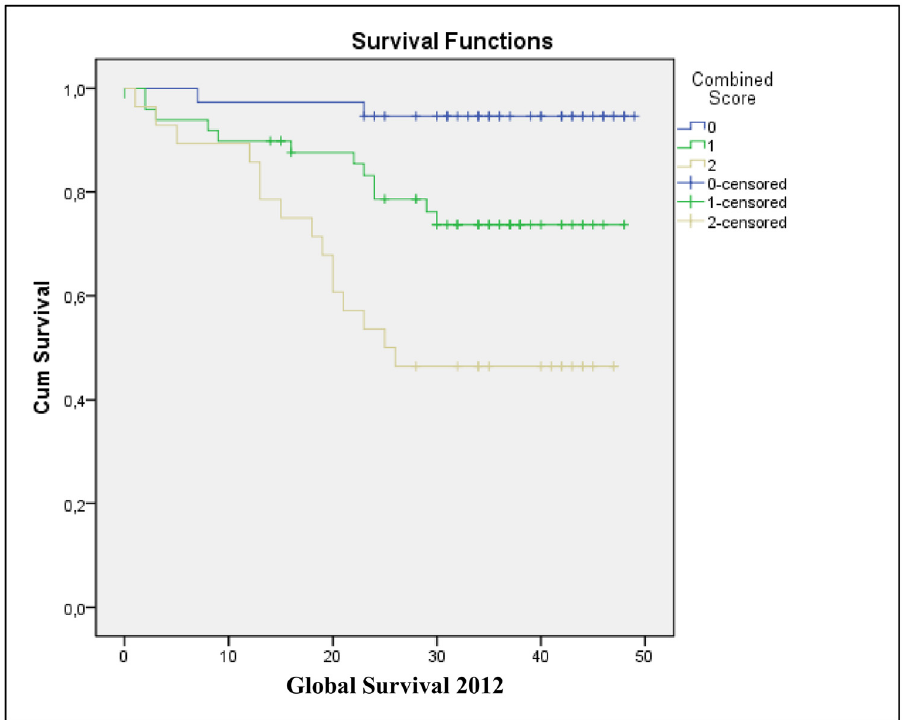
Fig 3. Kaplan-Meier GS curves for each category of the combined